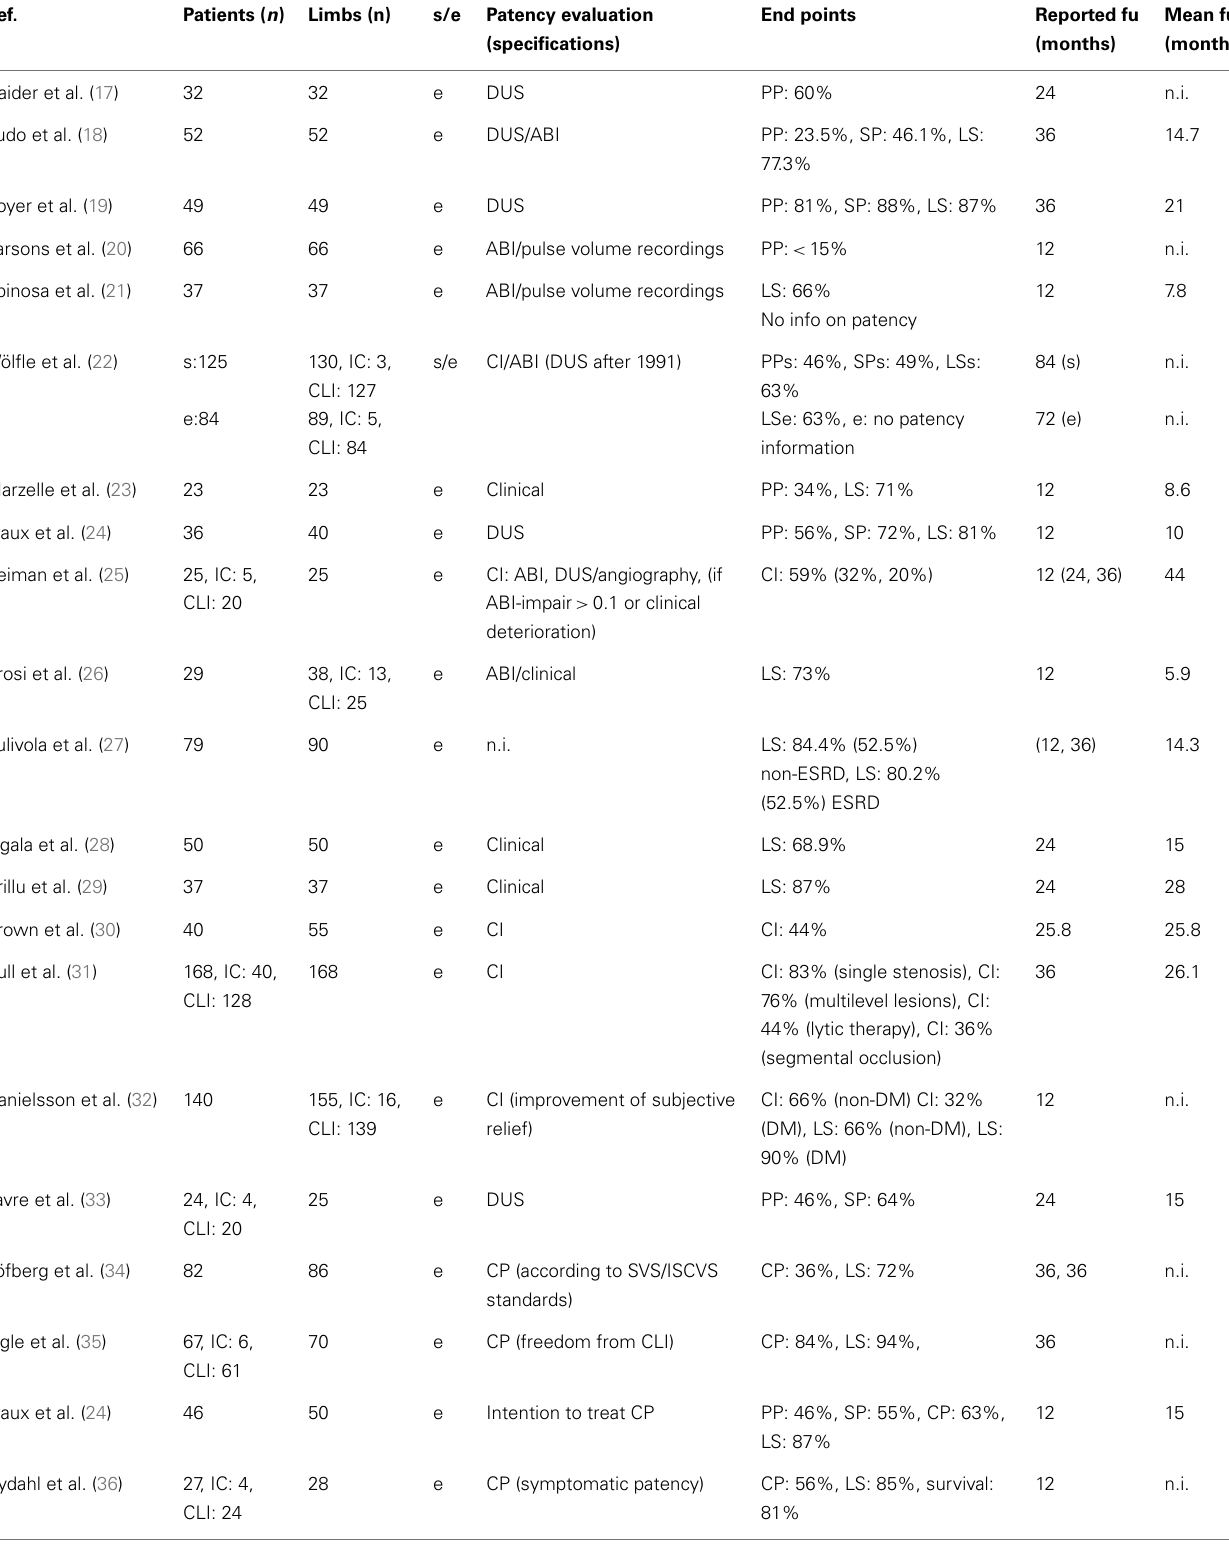
Table 1 | Summary of all studies analyzed within the meta-analysis of Romiti and coworkers .